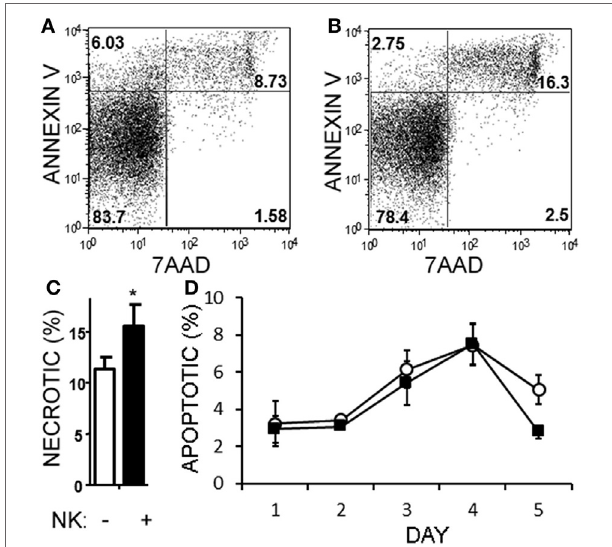
FigUre 7 | Natural killer (NK) cells are cytotoxic toward helper T (Th) cells through necrosis but not apoptosis. Memory CD4 + T cells from healthy subject PBMC were activated with anti-CD3, anti-CD28, and Th17 polarizing factors, either in the absence or presence of NK cells for 4 days. Samples were stained with CD3, CD56, 7AAD, and annexin V. Representative plots of T cells (CD4 + CD56 − ) cultured without (a) or with NK cells (B) are shown. The average proportion of necrotic (7-AAD + annexinV + ) T cells is shown (c) . Open bars = memory CD4 T cells, closed bars = memory CD4 + T cells plus NK cells. N = 8 samples. A time-course analysis of apoptotic (7-AAD − annexin V + ) T cells is shown (D) . Open circles indicate memory CD4 T cells alone and filled squares indicate T cells plus NK cells.